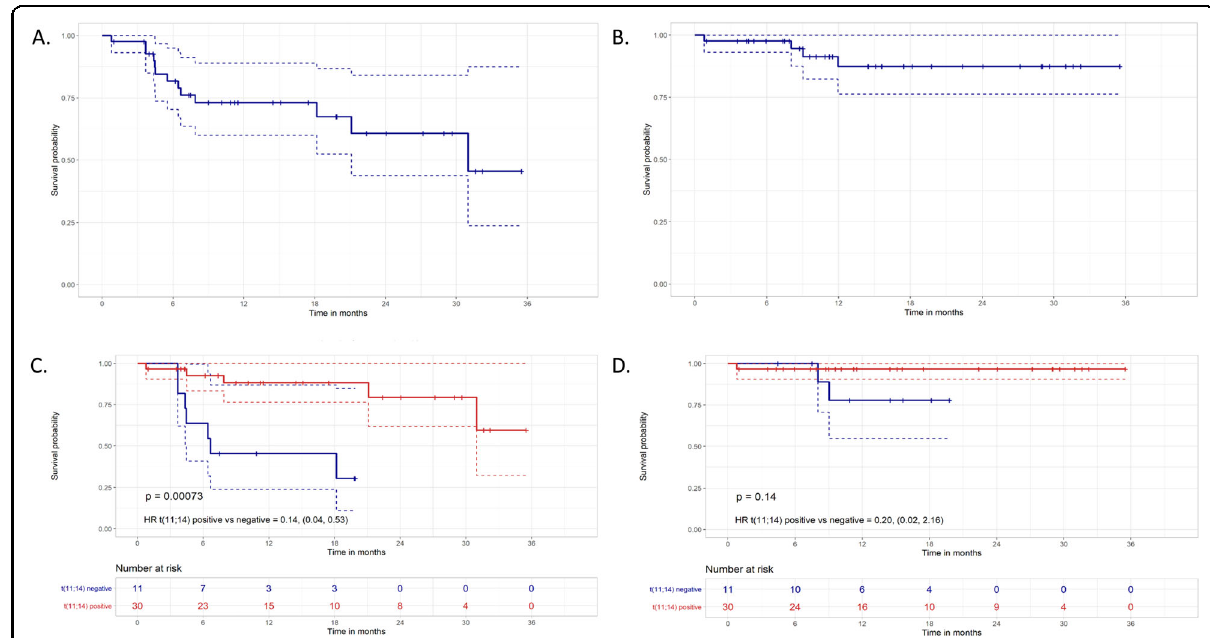
Fig. 2 Kaplan – Meier curves for progression-free survival (PFS) and overall survival. A PFS for the unsegregated cohort. B OS for the